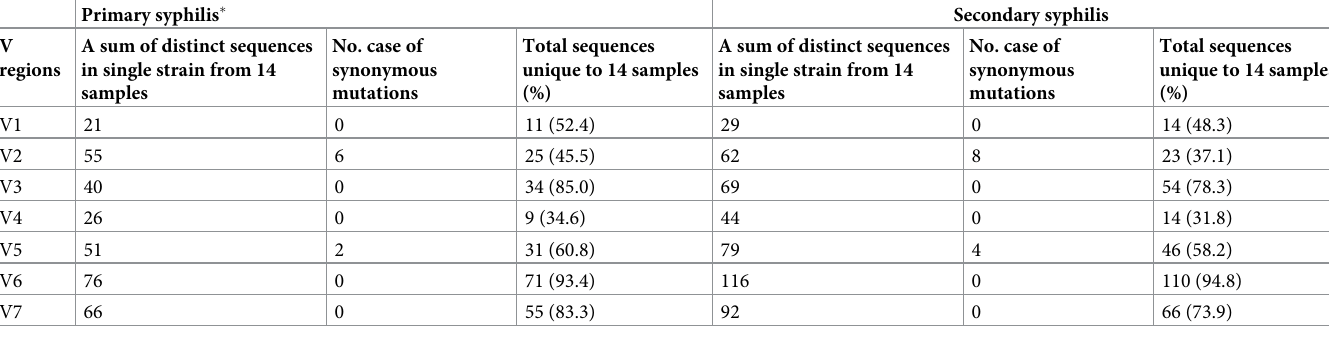
Table 2. Interstrain redundancy in amino acid sequences within seven V regions of the tprK gene in the primary and secondary samples. Primary syphilis � Secondary syphilis V A sum of distinct sequences regions in single strain from 14 samples